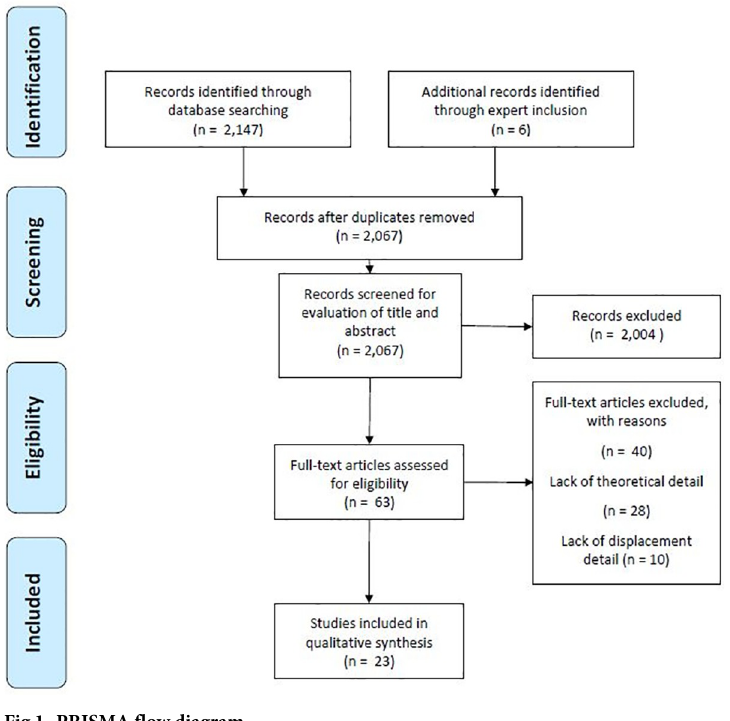
Fig 1. PRISMA flow